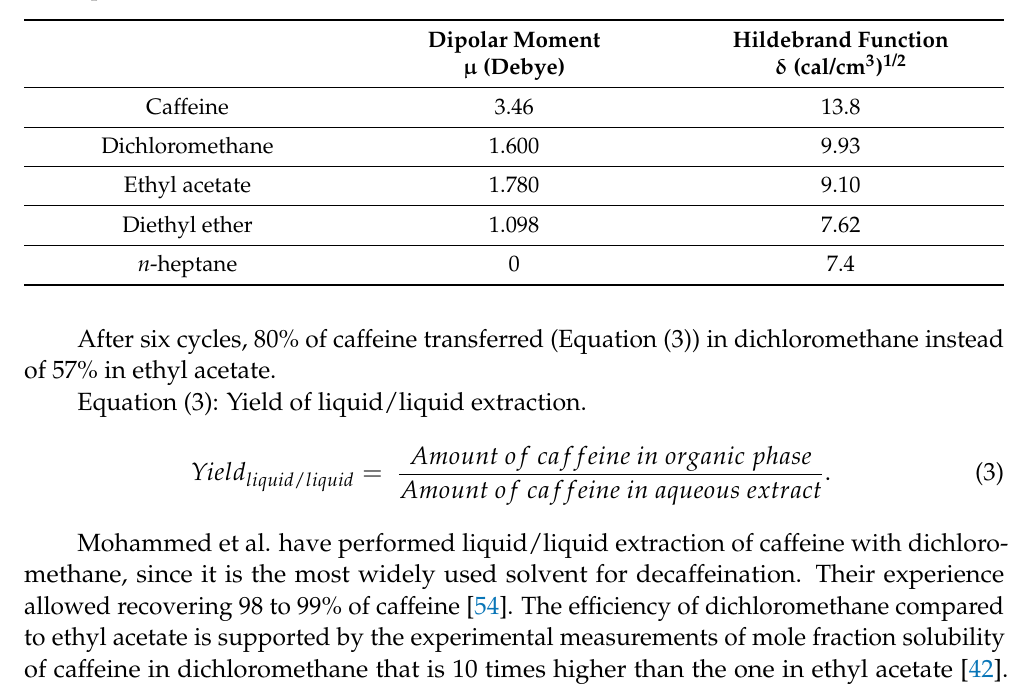
Figure 10. Evolution of the yield of caffeine transferred (%w) from aqueous extract (60 mL) into 6 × 10 mL of dichloromethane ( ▲ ) or ethyl acetate ( ) during liquid/liquid extraction at room temperature. Table 2. Dipolar moment µ and Hildebrand function δ of caffeine and organic solvents for liq- uid/liquid extraction